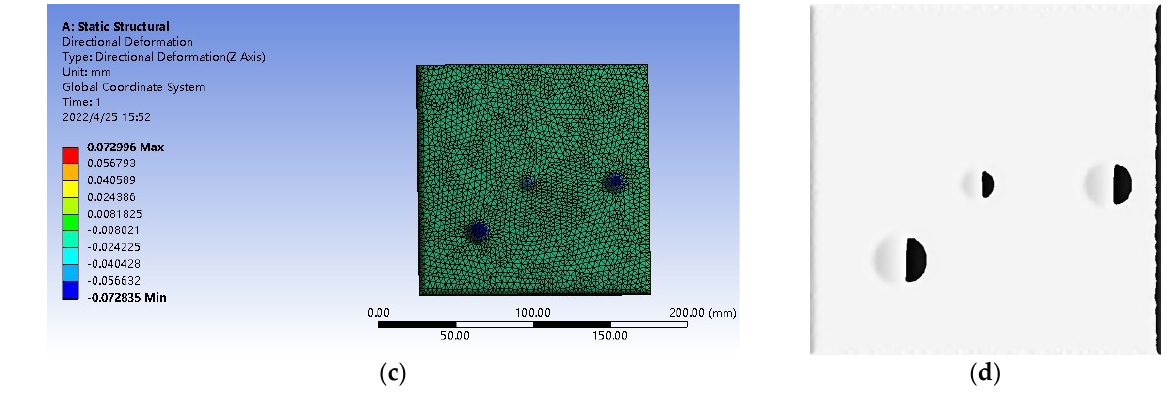
Figure 4. Deformation distributions and shearography images with thermal loads on 30 °C and 50 °C: ( a ) deformation, 30 °C; ( b ) shearography image, 30 °C; ( c ) deformation, 50 °C; ( d ) shearography image, 50 °C.